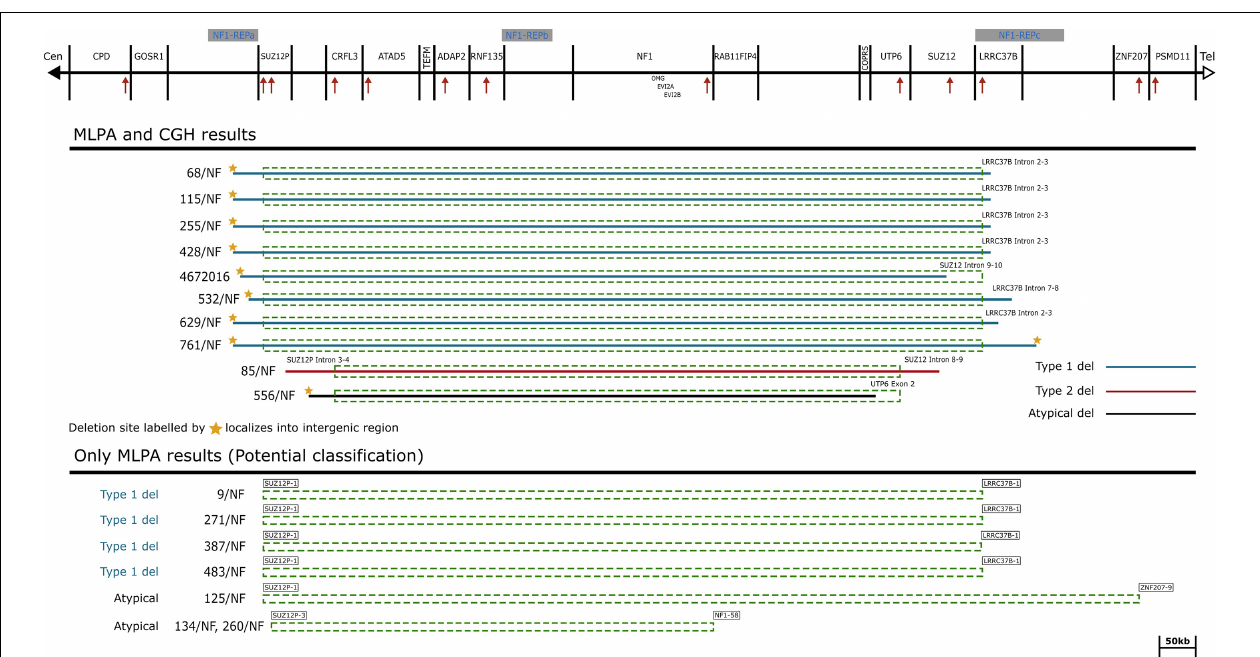
FIGURE 1 | Schematic representation of the NF1 gene and flanking regions. The affected genes and NF1-REP regions are schematically displayed at the top of the figure. Localization of MLPA probes are demonstrated by red arrows. Solid lines symbolize the deletion range with known breakpoints determined by aCGH probes. Dotted rectangles correspond to the deleted range determined by MLPA probes. Deletion types are marked by colored solid lines, blue: type-1 deletions, red: type-2 deletion and black: the suggested atypical deletion. The last probes contained by the deletion are explicitly displayed at the ends of the deletion